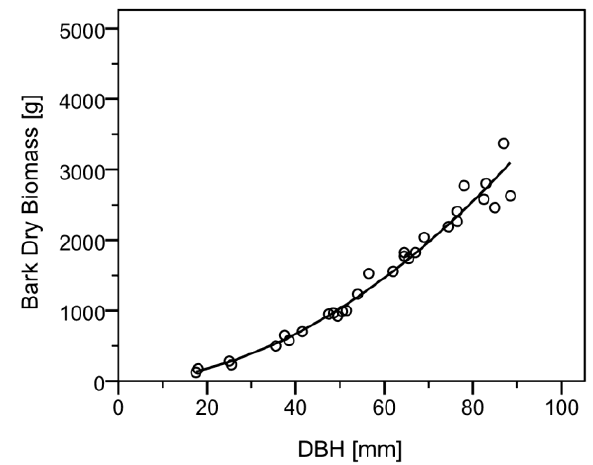
Figure 4. Biomass model for total above ground dry bark biomass. Parameters of the model applicable to Equation 3 are shown in Table